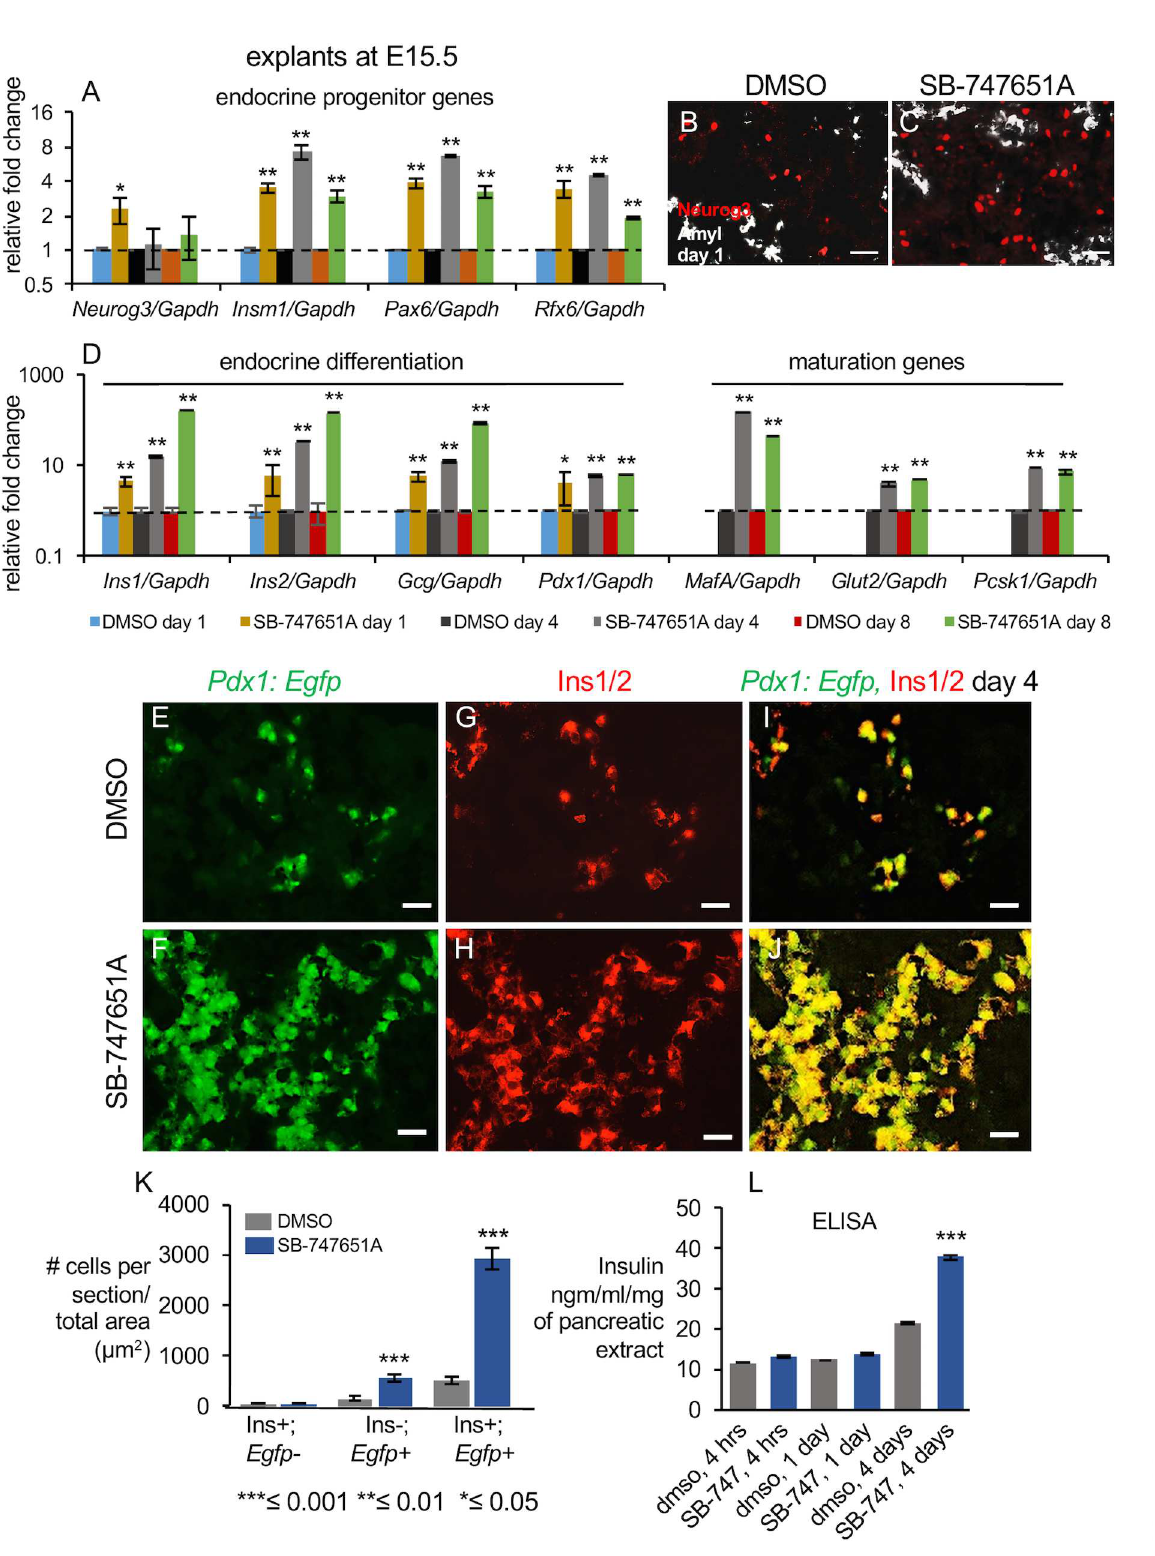
Fig 5. Pancreatic beta cell fate is markedlyincreased by SB-747651A treatment at E15.5. (A) Expression levels of indicated endocrine progenitorgenes on days 1, 4, and 8 of SB-747651A treatment in explantsharvestedfrom E15.5 stage. Y-axis